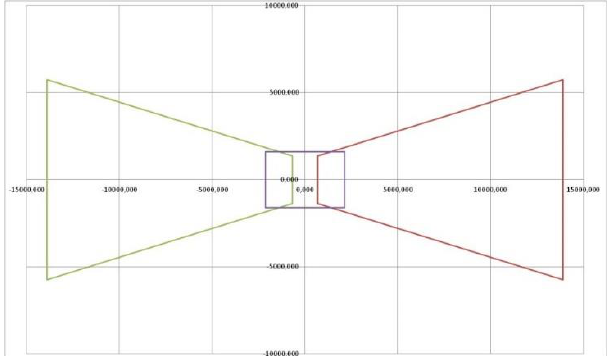
Figure 4. Camera footprints of the mid-altitude configuration, flight direction is up